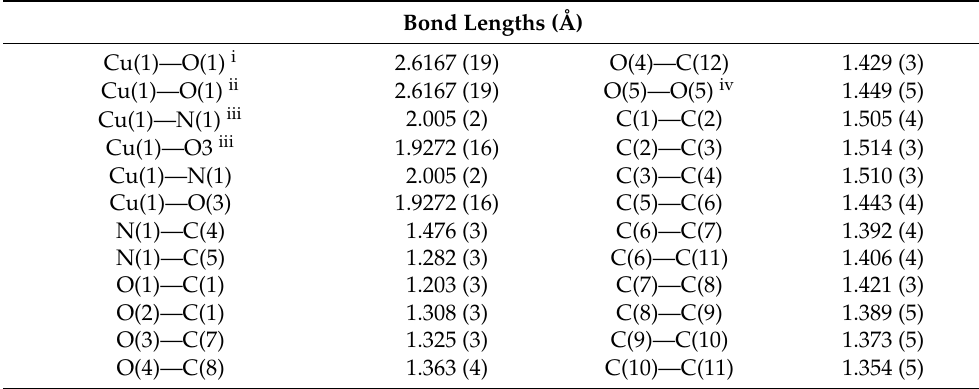
Figure 1. ( A ) The fully coordinated monomeric complex unit of 4 . Carbon group hydrogen atoms and lattice solvent molecule have been omitted. ( B ) Part of the polymeric chain of 4 and hydrogen bonding interactions (light blue dotted lines). Table 2. Bond lengths [Å ] and angles [ o ] for 4 .